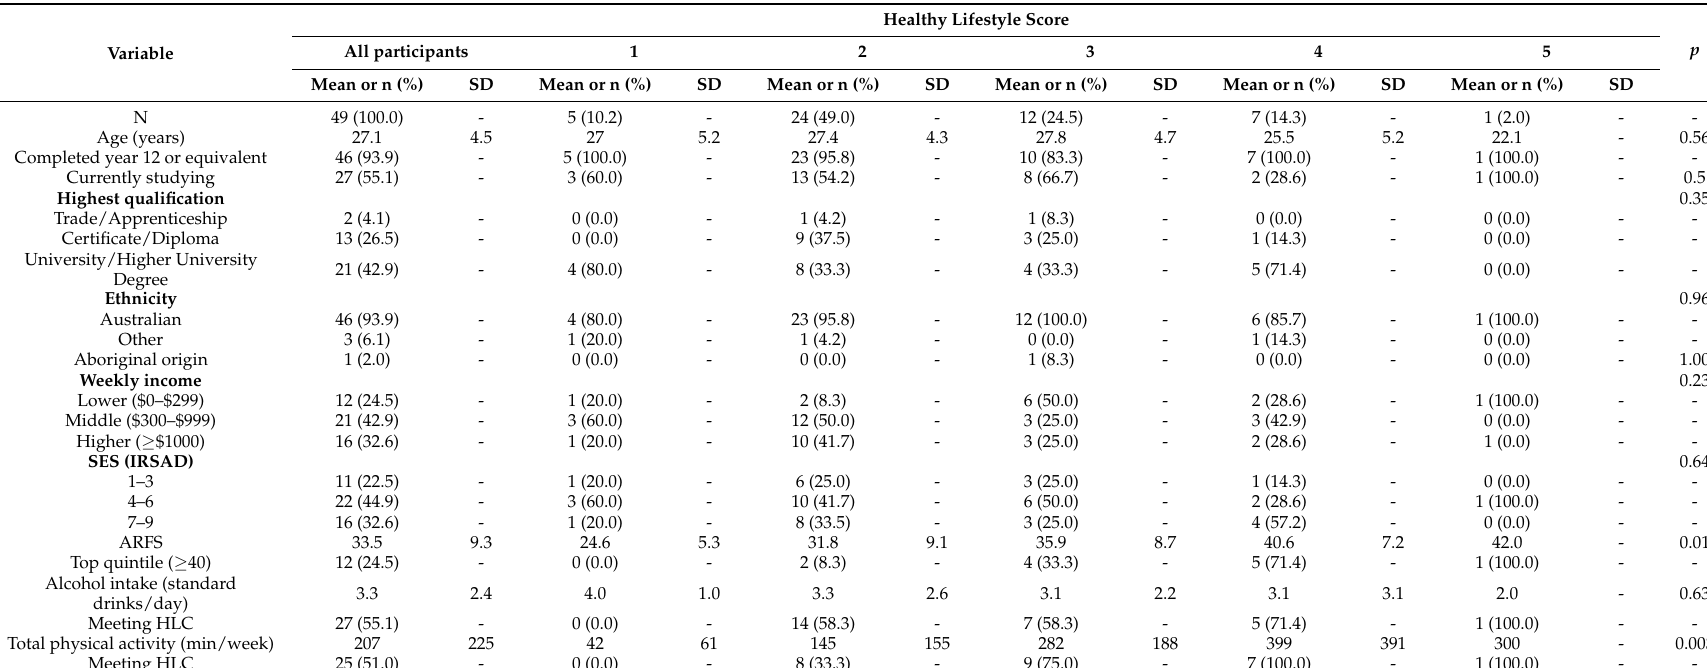
Table 1. Baseline characteristics of young (18–35 years) overweight and obese women (BMI 25–34.9 kg/m 2 ) entering a weight-loss trial ( n = 49 1 ), by Healthy Lifestyle